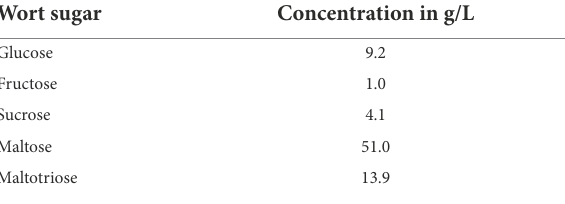
TABLE 5 Sugar composition of the wort used for fermentation trials. Wort